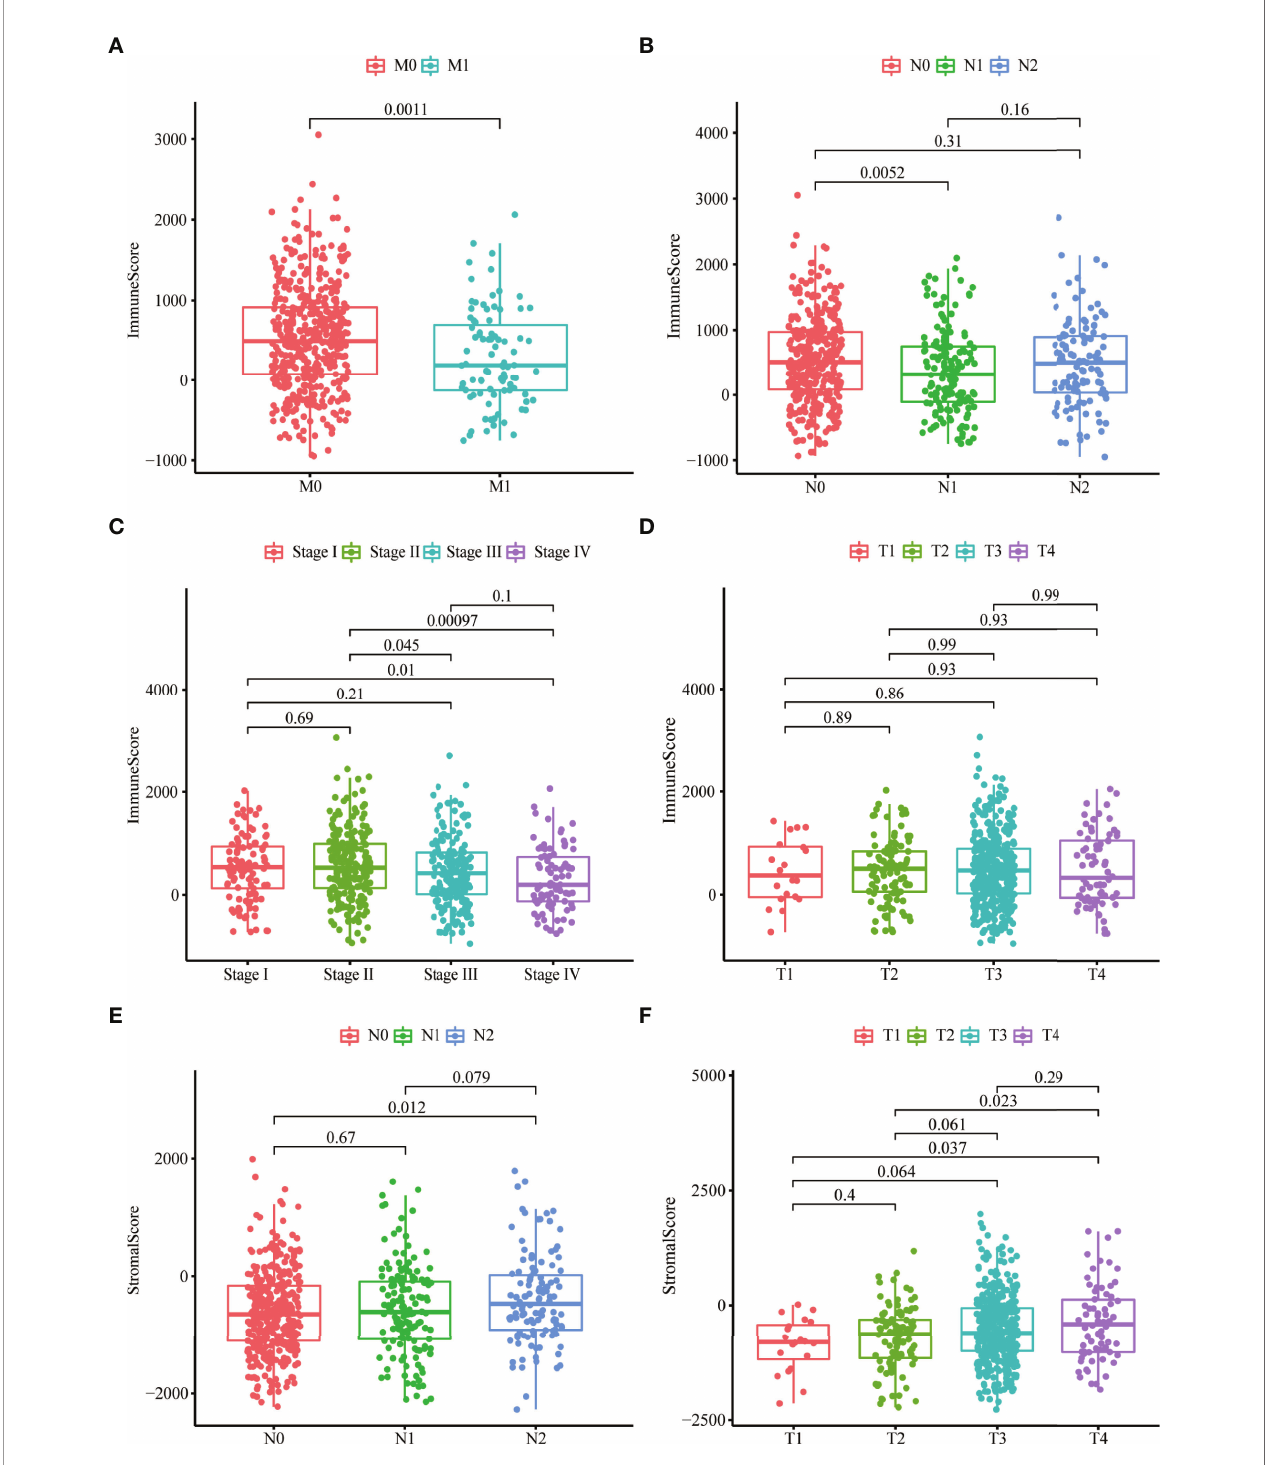
FIGURE 1 | Stromal and immune scores were markedly related to colon cancer stages. (A – D) Distribution of immune scores in nonmetastatic (M0) patients and distant metastases (M1) patients (A) , N0-2 patients (B) , stage I – IV patients (C) , T1 – 4 patients (D) . (E, F) Distribution of stromal scores in N0-2 patients (E) and T1-4 patients (F)